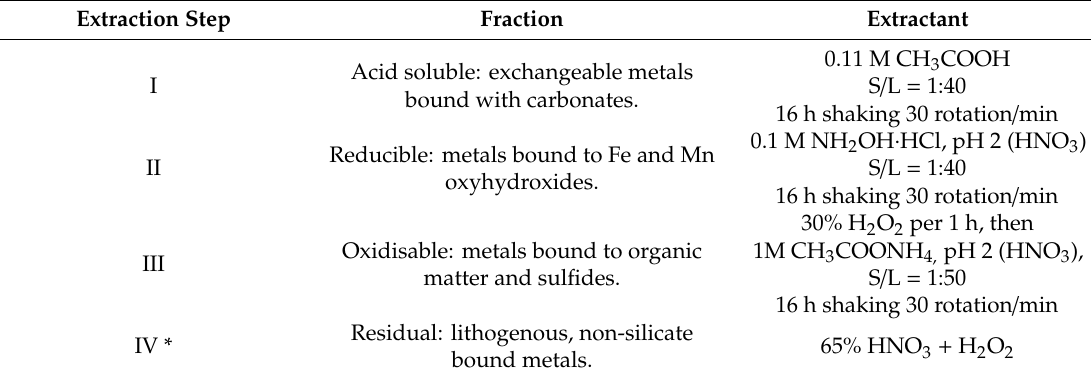
Table 1. BCR speciation protocol.